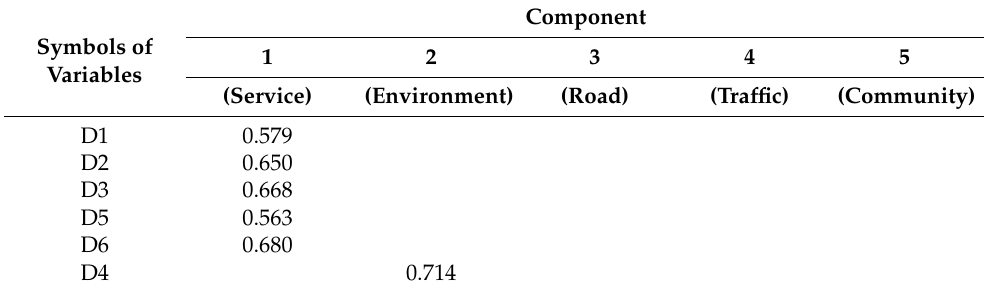
Table 5. Rotation component